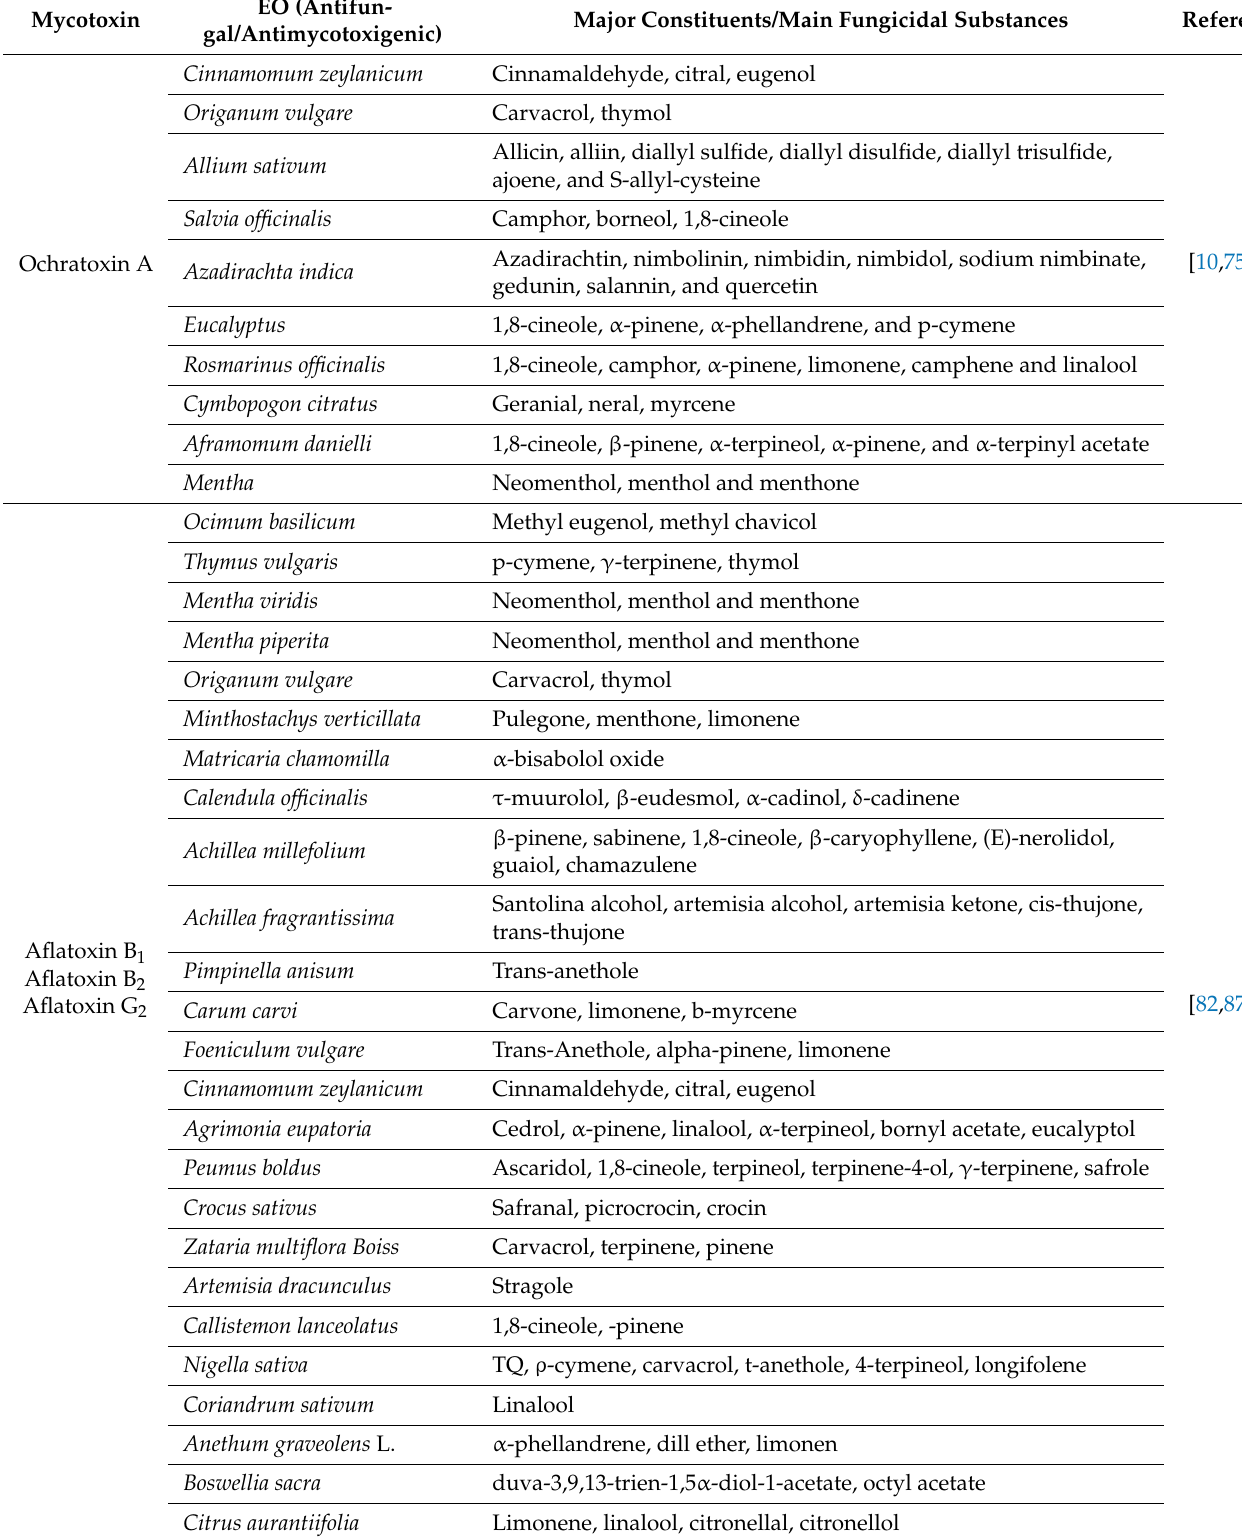
Table 3. EO used in experimental studies for mycotoxins prevention or